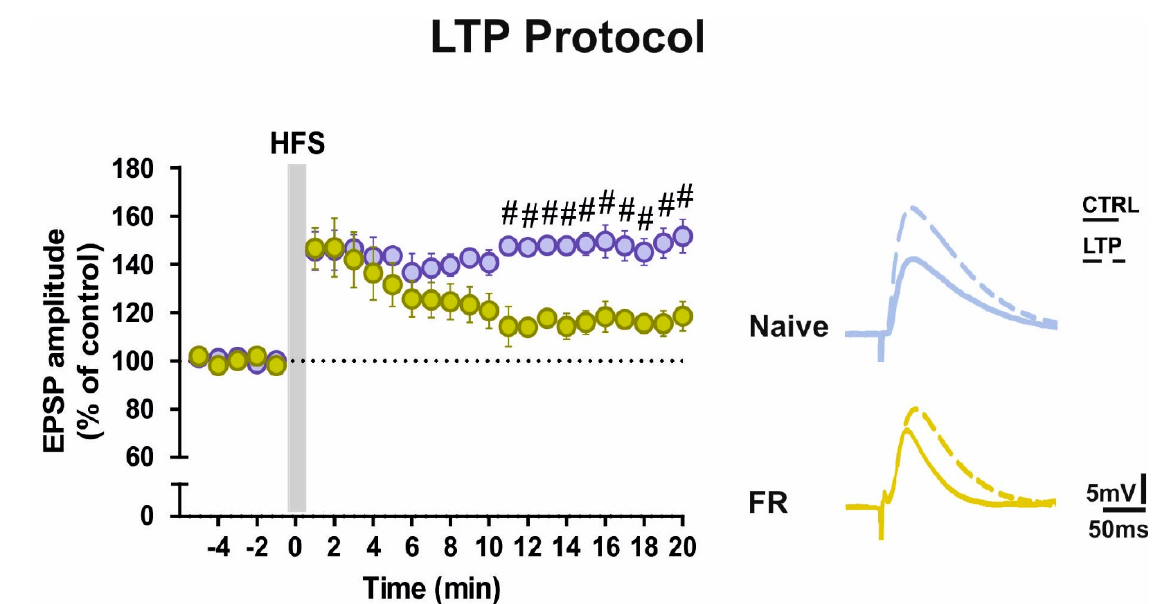
Figure 3. AMPAR subunit composition is critical for the maintenance of long-term potentiation (LTP). Left panel: time course of EPSP amplitude of SPNs from Naïve and FR mice after induction of LTP protocol. Grouped analysis shows significant group effect (two-way ANOVA: time x group interaction F (24,264) = 4.23, 11–20 min, Bonferroni’s post hoc # p < 0.05). The scale factor is 50 ms/5 mV for all traces. Right panel: representative traces of single SPNs recorded from Naïve and FR mice before (solid lines) and after HFS (dotted lines).